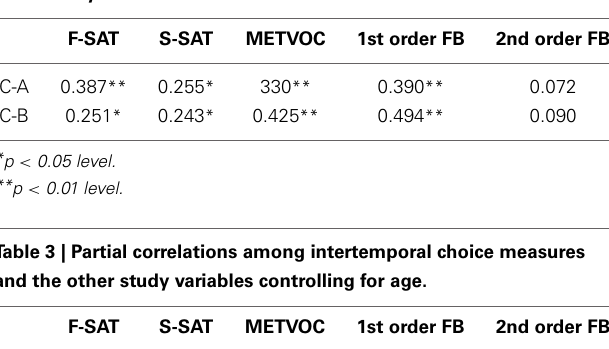
Table 2 | Correlations among intertemporal choice measures and the other study variables.